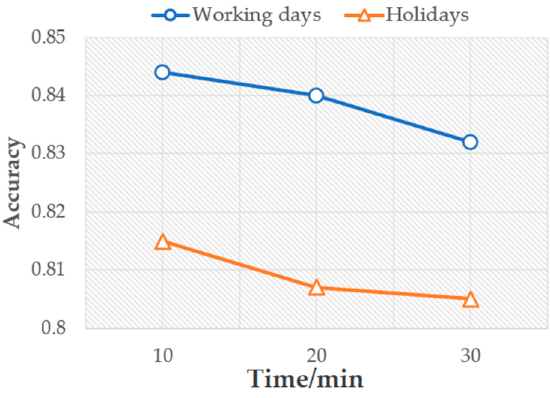
Figure 10. The plot of the results of the multistep prediction of the DC-STGCN model.